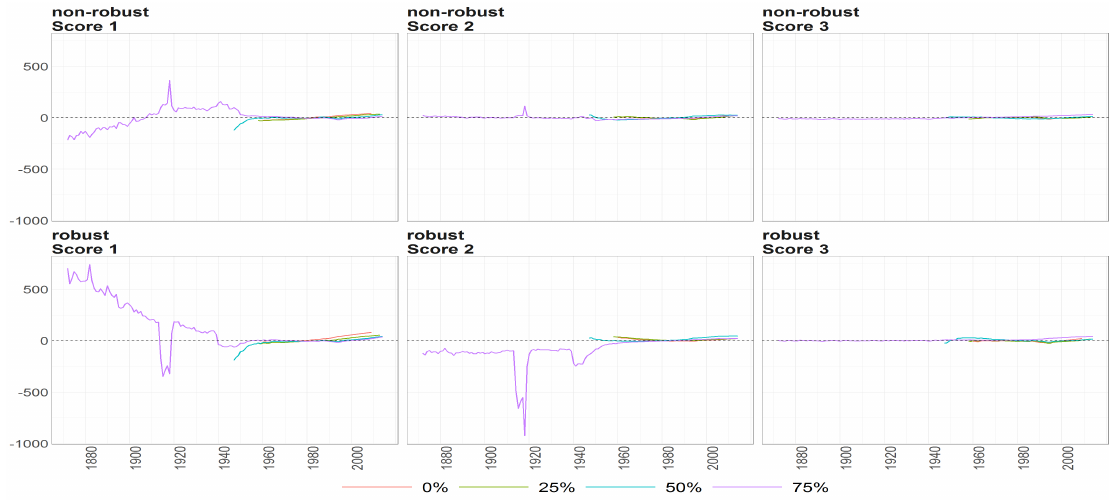
Figure 26. The scores (y axis) over time (x axis) obtained using PPCA for male population of Death Rates. Colours of lines correspond to the scores calculated on subsample where are different levels of maximum missing values per observation (0%, 25%, 50% and 75%, refer to legend). The plots placed in the first row correspond to the results using non- robust standardization of entry data, where the second row correspond to robust standardisation. The plots of scores are ordered by